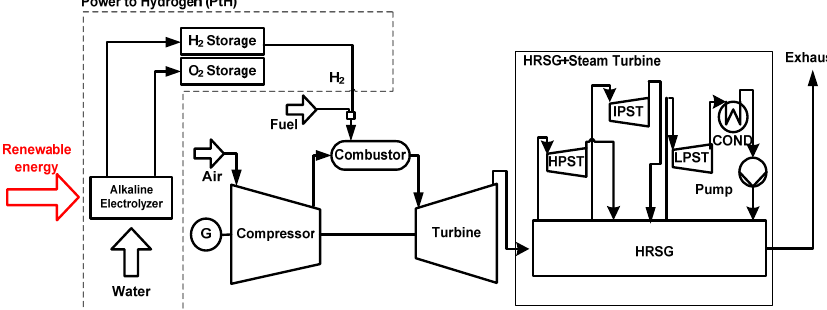
Figure 2. Configuration of Case 2.